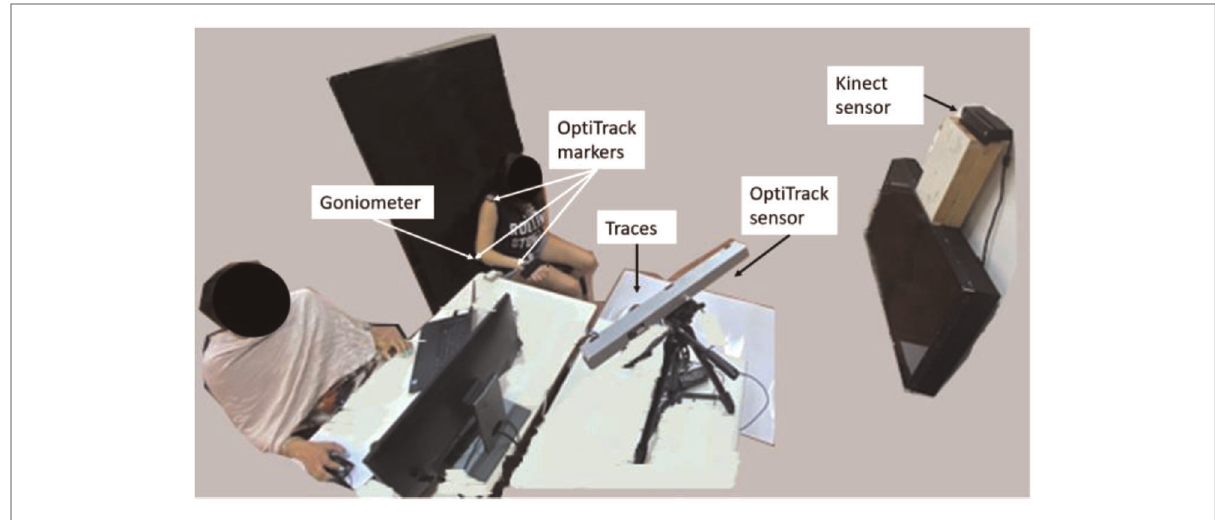
FIGURE 3 Experiment environment. The participant is seated on an armless chair with her hand strapped to the manipulator, about 2 m in front of the Kinect sensor. The goniometer and three V120:Trio re fl ectors are connected to the participant ’ s